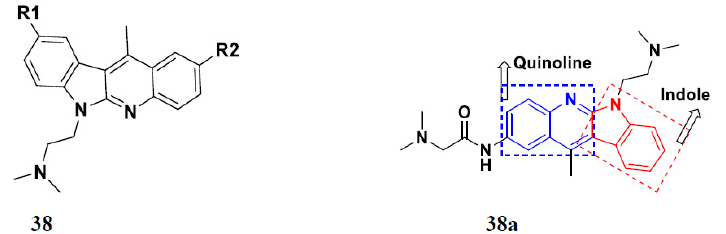
Figure 42. Structure of quinoline-indole based hybrids and the most promising compound 38a . Table 31. In vitro cytotoxic activities of quinoline-indole based hybrid compounds 38 ( b – e ).